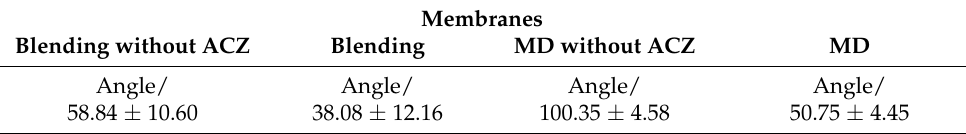
Table 6. Water membrane contact angles (Mean ± SD, n =